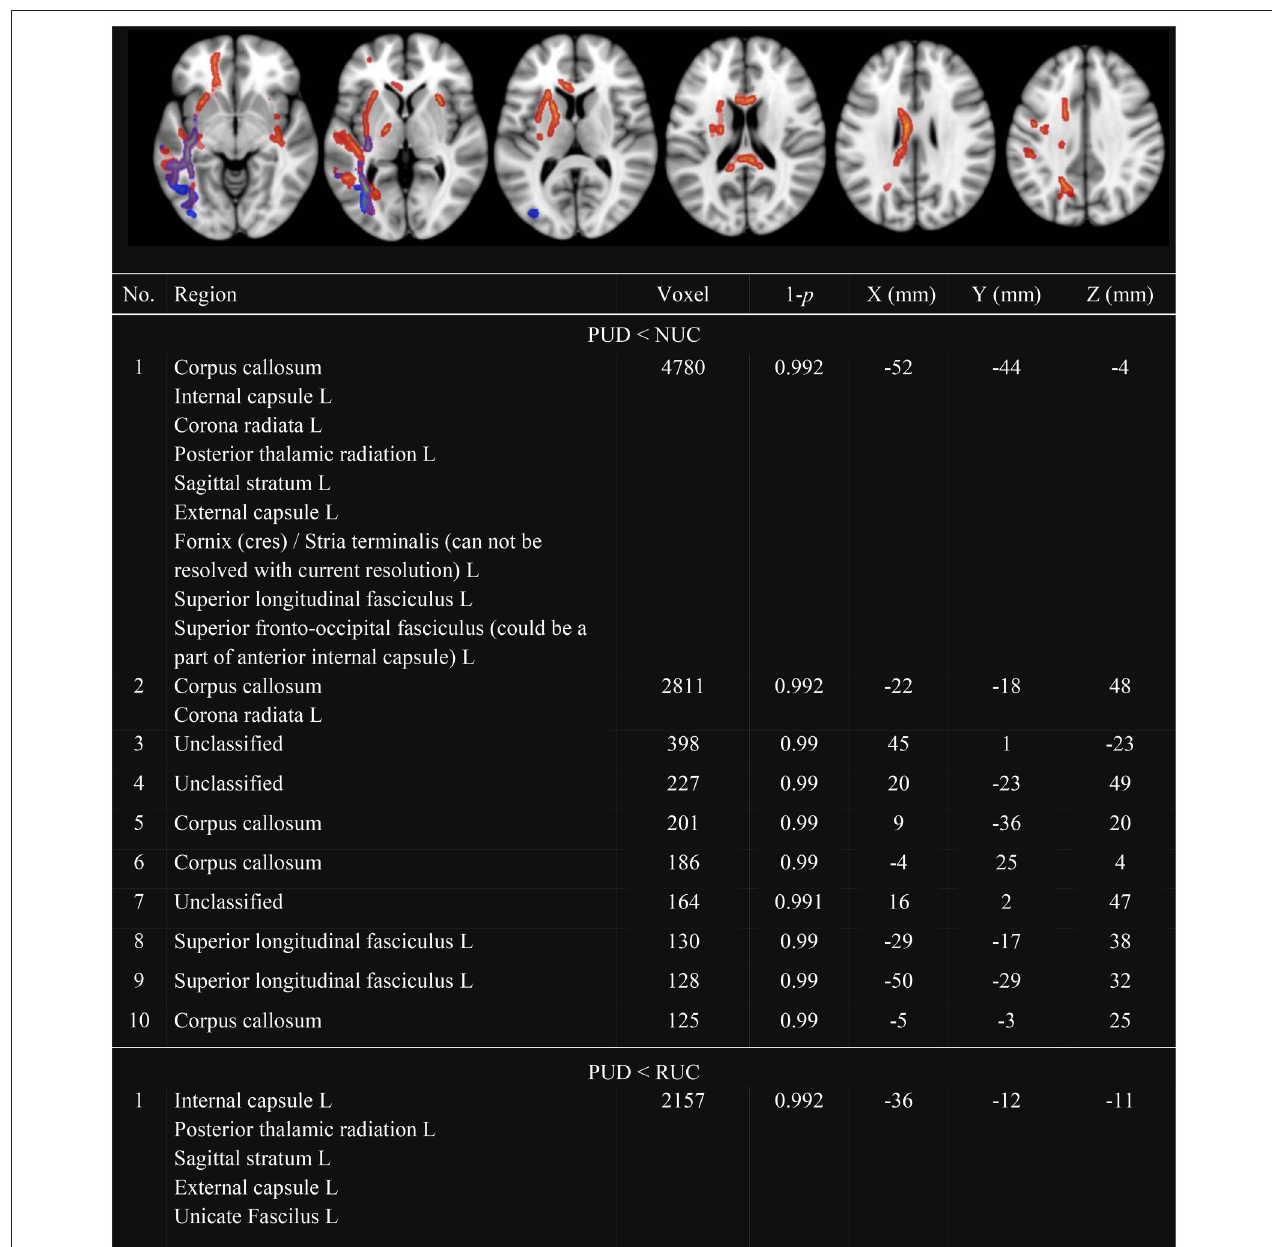
FIGURE 2 | Clusters with decreased MD in PUD compared to NUC and RUC. Only Clusters with a size more than 100 voxel are presented. MD, Mean Diffusivity; NUC, Non-using controls; RUC, Recreational using controls; PUD, Poly-drug use disordered patients; PUD < NUC, Decreased MD in PUD in comparison to NUC (red-yellow); PUD < RUC, Decreased MD in PUD in comparison to RUC (blue-green); No., Number; Region, Included regions according to JHU ICBM-DTI-81 White-Matter Labels; R, Right; L, Left; Voxel, Number of voxel per cluster; 1- p = Statistical peak-value for each cluster; X –Y– Z (mm) = Peak-coordinates for each cluster. Significantly different clusters have been thickened with the FMRIB Software Library option